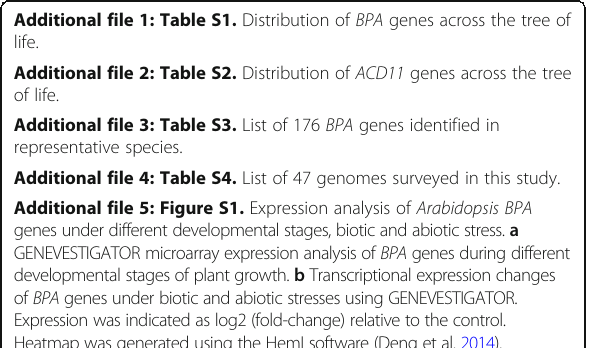
Additional file 1: Table S1. Distribution of BPA genes across the tree of life. Additional file 2: Table S2. Distribution of ACD11 genes across the tree of life. Additional file 3: Table S3. List of 176 BPA genes identified in representative species. Additional file 4: Table S4. List of 47 genomes surveyed in this study. Additional file 5: Figure S1. Expression analysis of Arabidopsis BPA genes under different developmental stages, biotic and abiotic stress. a GENEVESTIGATOR microarray expression analysis of BPA genes during different developmental stages of plant growth. b Transcriptional expression changes of BPA genes under biotic and abiotic stresses using GENEVESTIGATOR. Expression was indicated as log2 (fold-change) relative to the control. Heatmap was generated using the HemI software (Deng et al.